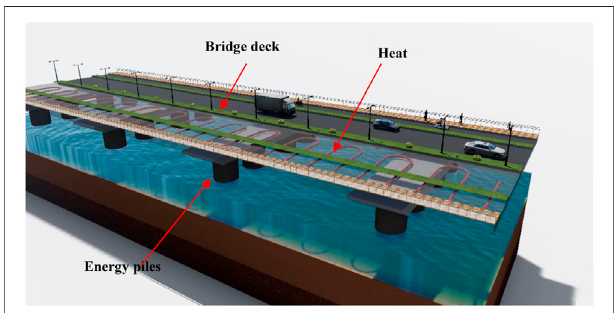
FIGURE 1 | The bridge deck deicing system using energy